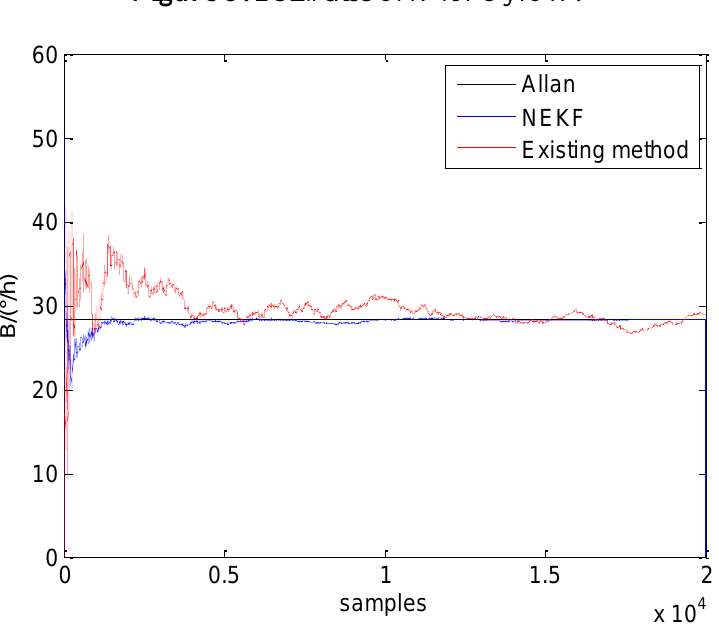
Figure 9. Estimates of N for Gyro X.